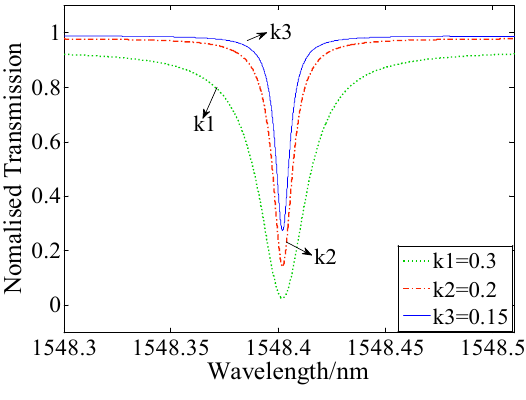
Figure 3. Resonance spectrums with different coupling ratios ( R = 20 μm)